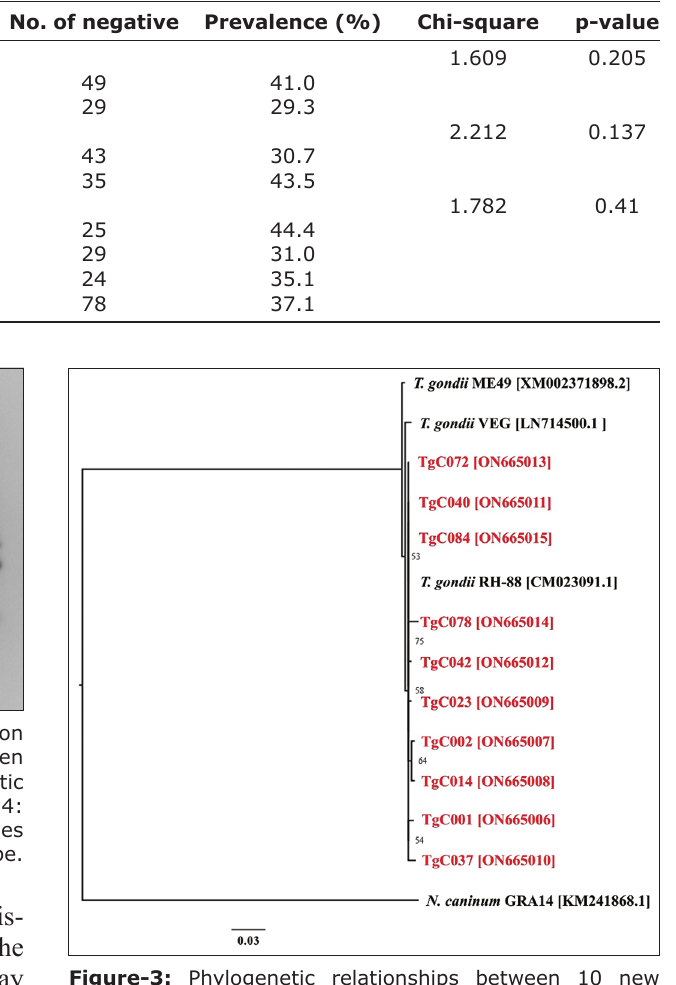
Figure-3: Phylogenetic relationships between 10 new Toxoplasma gondii isolates from domestic cats in Phayao, Thailand, and T. gondii type I-III reference strains based on their granule antigen 6 sequences. The phylogenetic tree was generated with 1000 bootstrap replicates using PhyML. Only bootstrap values of 50% or more are indicated at the nodes. Sequences from the present study are labeled in red